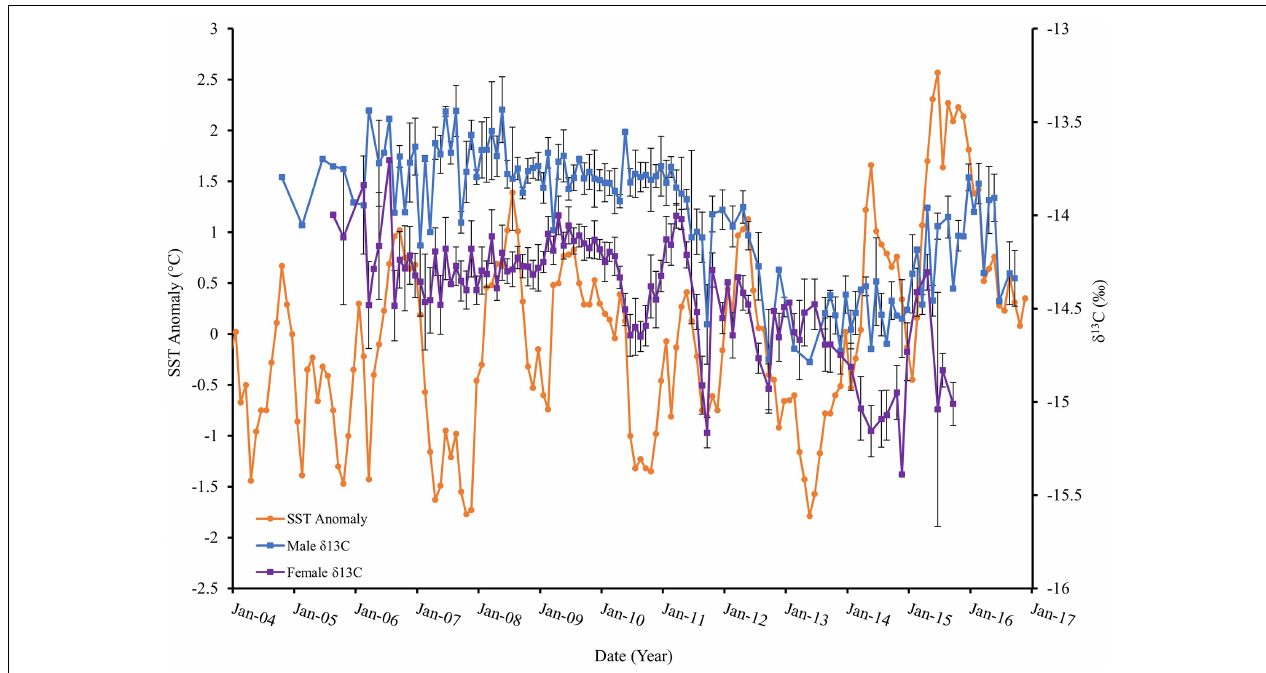
FIGURE 6 | Peruvian fur seal male mean δ 13 C (blue) and female mean δ 13 C (purple) measured in parts per thousand (